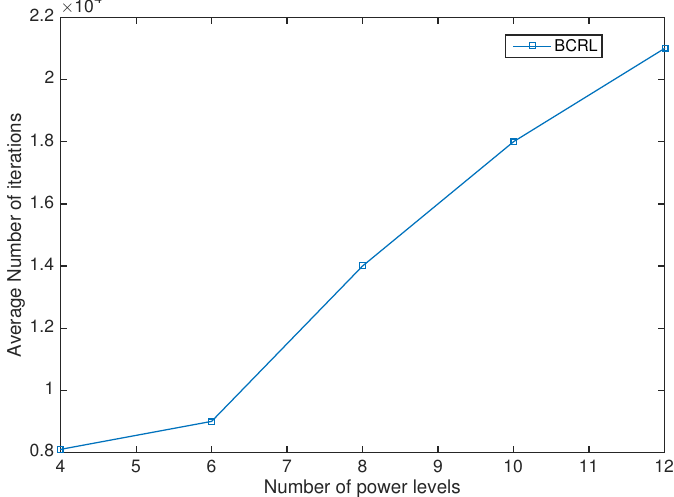
Figure 9. Number of iterations to convergence versus the power